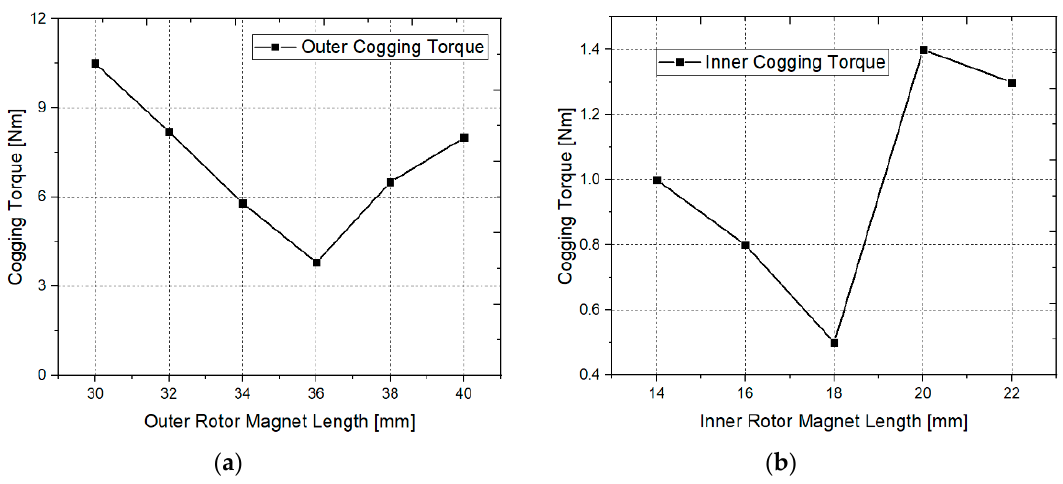
Figure 5. Analysis of cogging torque according to the dual rotor magnet length. ( a ) Change in permanent magnet length of outer rotor; ( b ) Change in permanent magnet length of inner rotor.